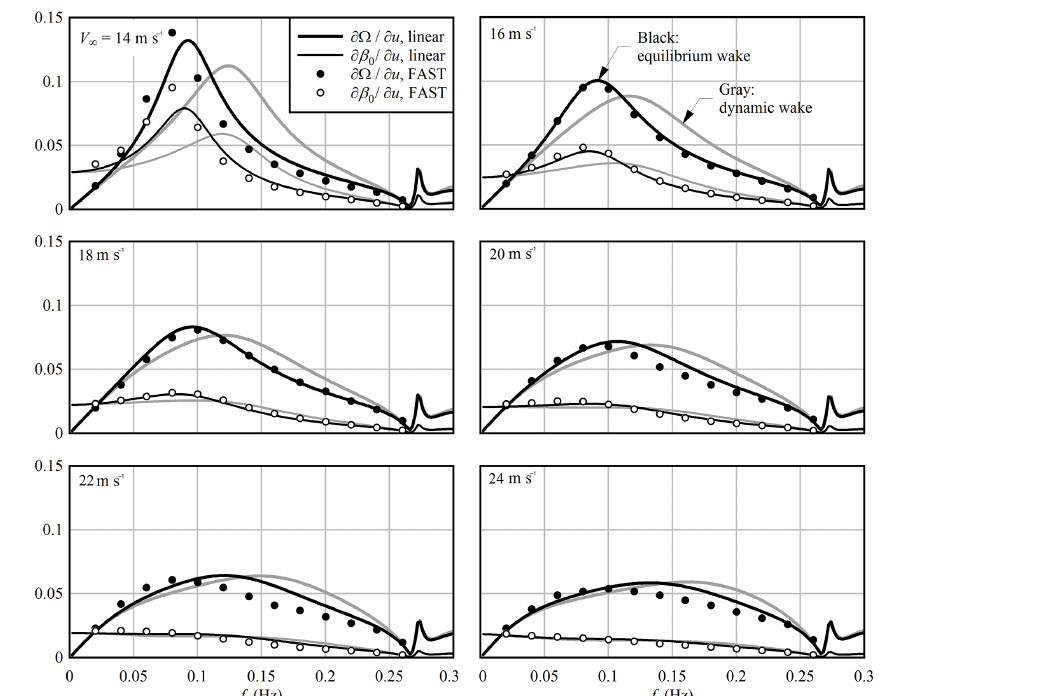
Figure 5. Closed-loop transfer functions of collective blade pitch (thin lines) and rotor speed (thick lines) with respect to a uniform sinusoidal perturbation in the axial wind speed. Nonlinear time-domain computations using FAST v8 are compared to equivalent results from a linear state-space model, obtained using equilibrium and dynamic wakes. The FAST results should be compared to the equilibrium-wake (black)